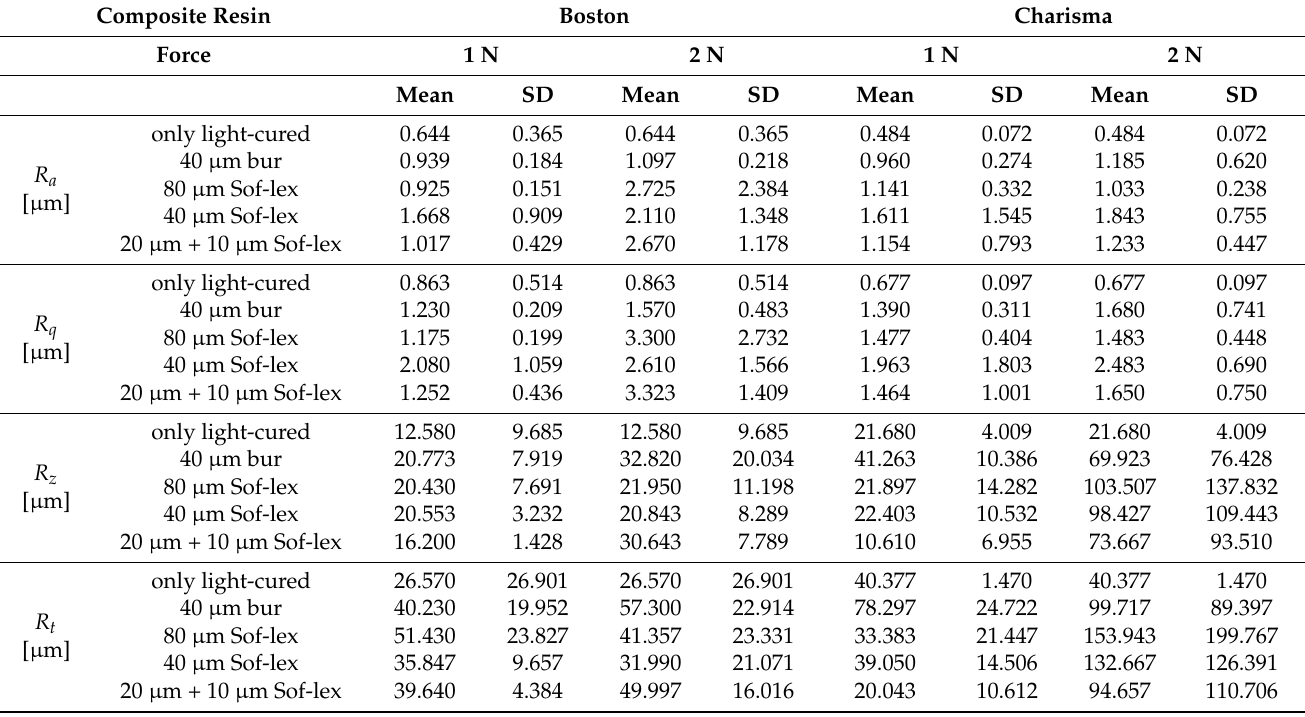
Table 3. Analysis of Values of Selected Indices of Profilometric Examination.